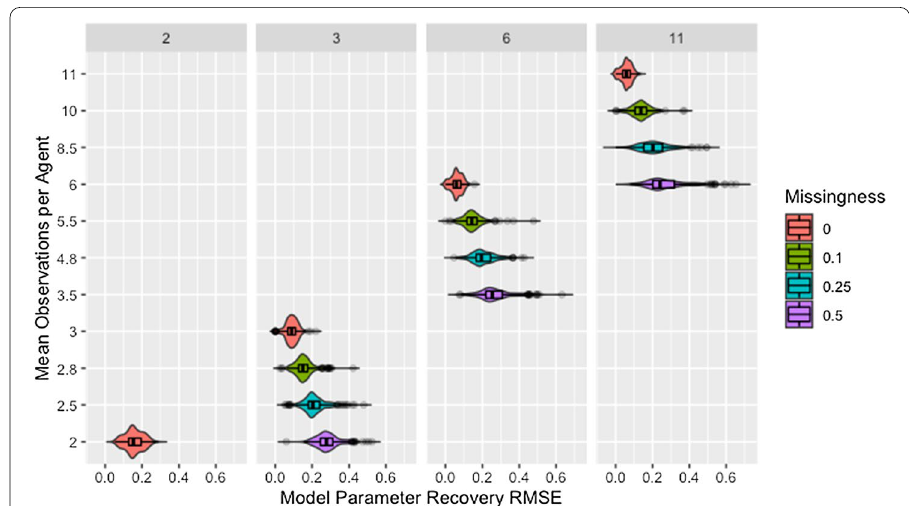
Fig. 9 Observations by RMSE for model parameter recovery, missingness, and time steps. Mean number of observations per agent by RMSE for known and predicted weights, proportion of missing data past initial, and number of time steps across